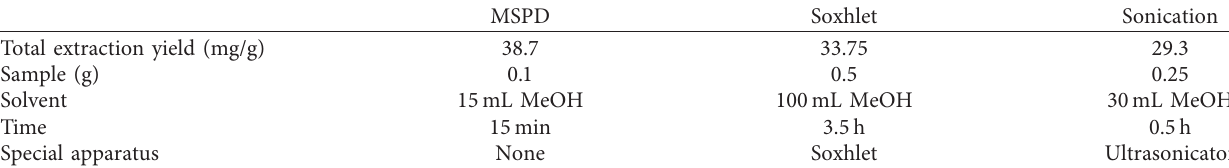
Table 5: Comparison of MSPD with other extraction methods for the extraction of main furanosesquiterpenoids from C. myrrha